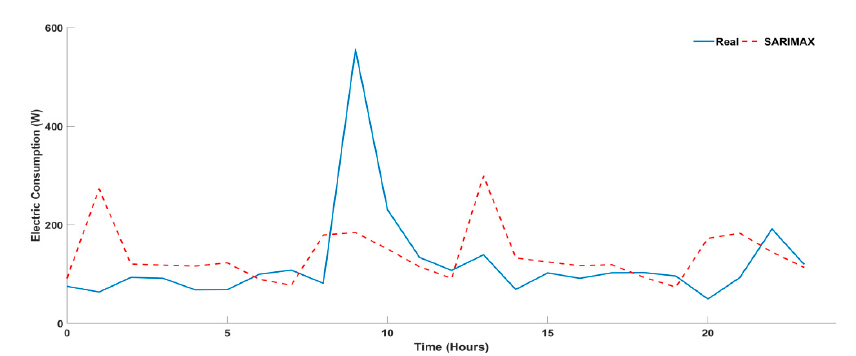
Figure 11. SARIMAX for 24-h ahead forecasting .